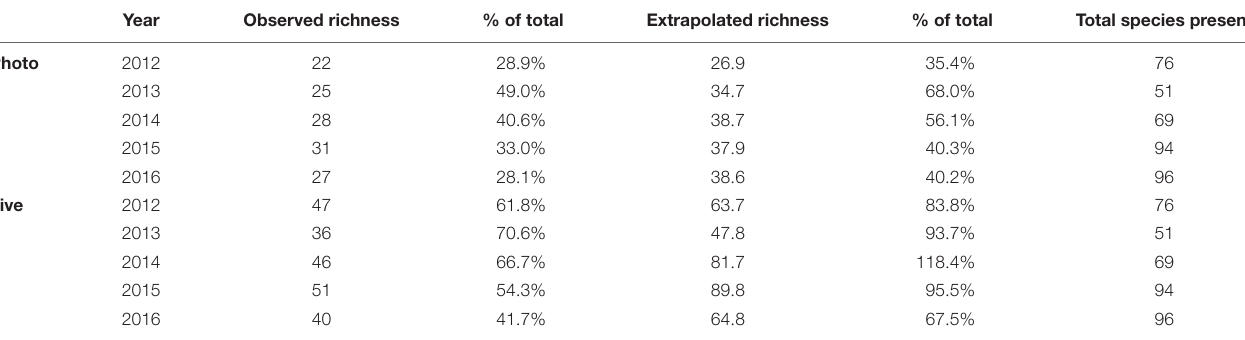
TABLE 1 | Richness scores calculated per year for the two measured point count methods, along with the extrapolated richness scores for the point count methods, the respective percentage of the total observed species those measurements reflect, and the measured total species